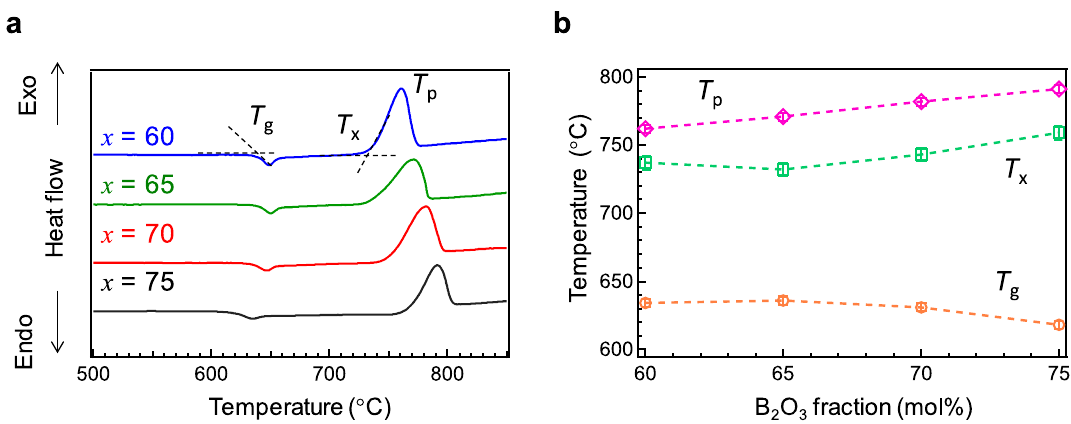
Figure 1. Thermal properties of Ce:SBO x glasses. ( a ) DTA curves of Ce:SBO x glasses and the glass transition temperature ( T g ), crystallization onset temperature ( T x ), and crystallization peak temperature ( T p ). ( b ) Variations in T g , T x , and T p as a function of B 2 O 3